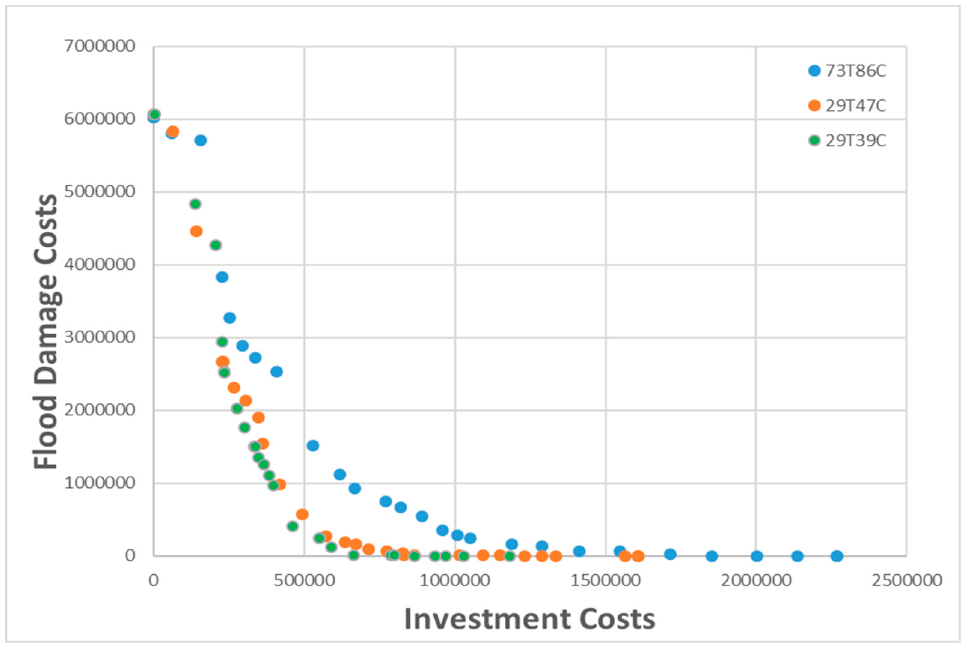
Figure 7. Pareto fronts representation of three different models.